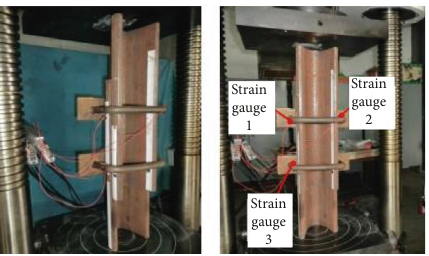
Figure 1: U -shape steel axial bearing capacity test device.